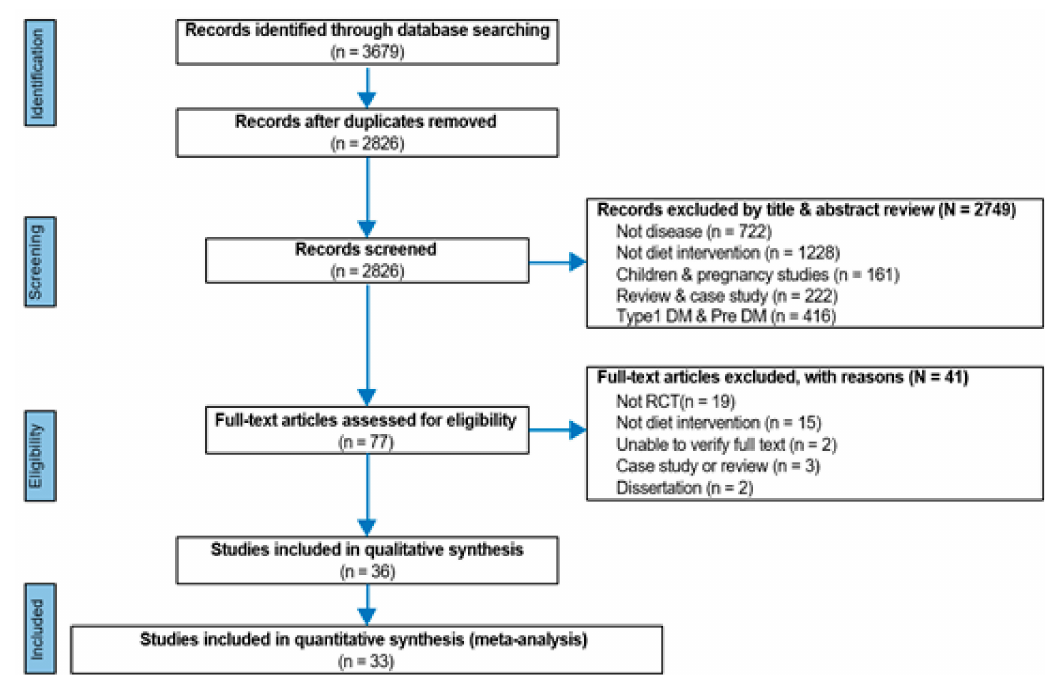
Figure 1. Flowchart of the study selection process. DM = Diabetes mellitus, RCT = Randomized controlled trial.